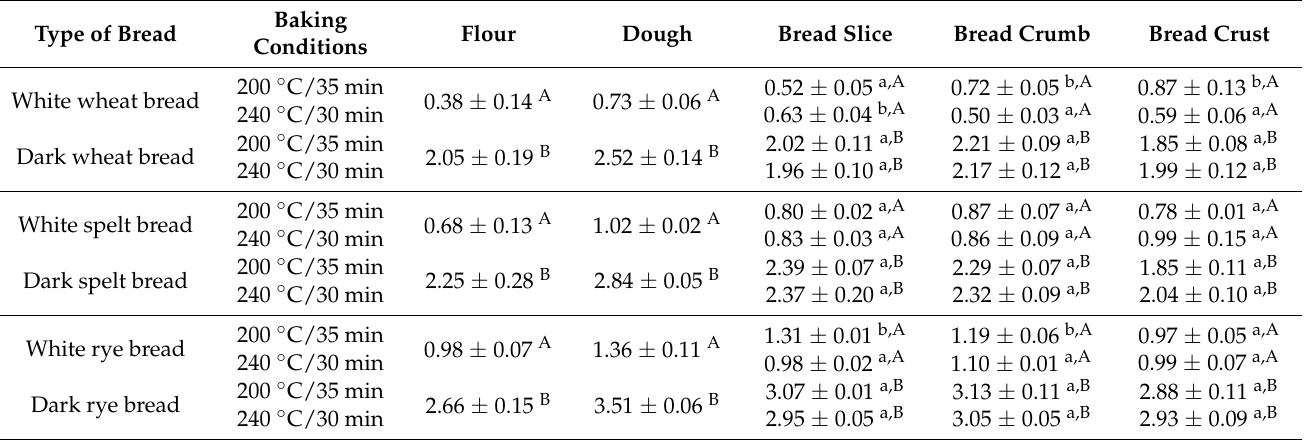
Table 2. The reducing capacity of the lipophilic (L-RC) fraction from flours, doughs, slices, crumbs, and crusts originated from white and dark wheat, spelt, and rye breads baked at 200 ◦ C for 35 min or at 240 ◦ C for 30 min ( µ mol Trolox/g DMr).